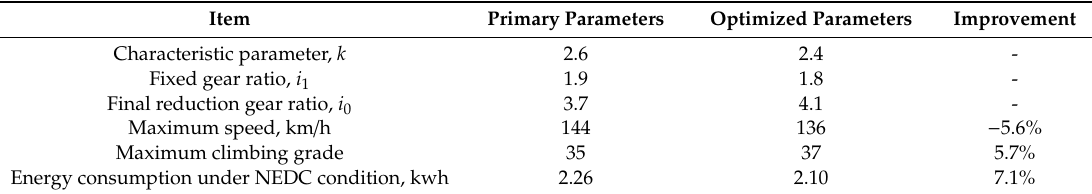
Table 5. Parameter comparison after optimization.